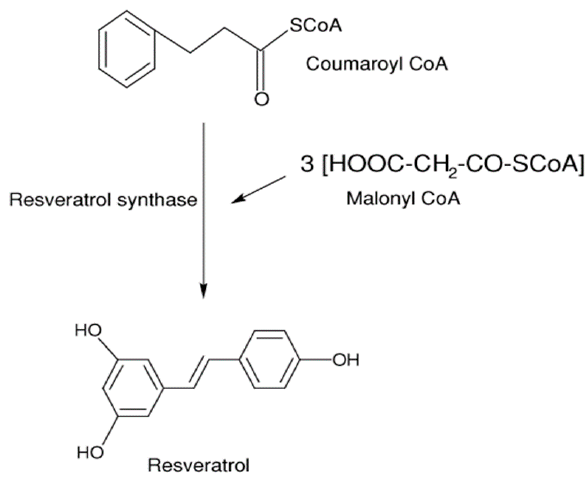
Figure 2. Resveratrol synthesis from malonyl-CoA and 4-coumaroyl CoA [43].